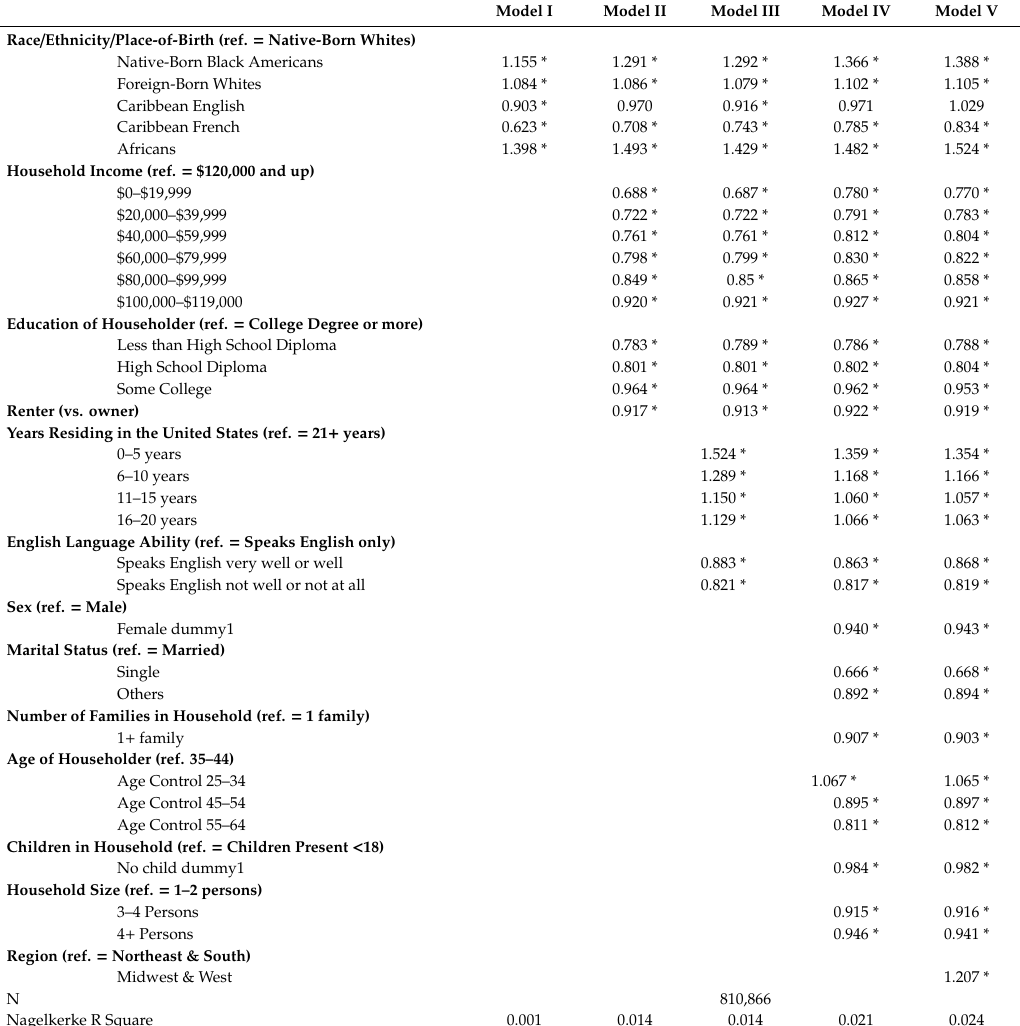
Table 3. Binary Logistic Regression Odds Ratios Predicting Suburban Residence Type (vs. Mature Suburbs)—Pooled